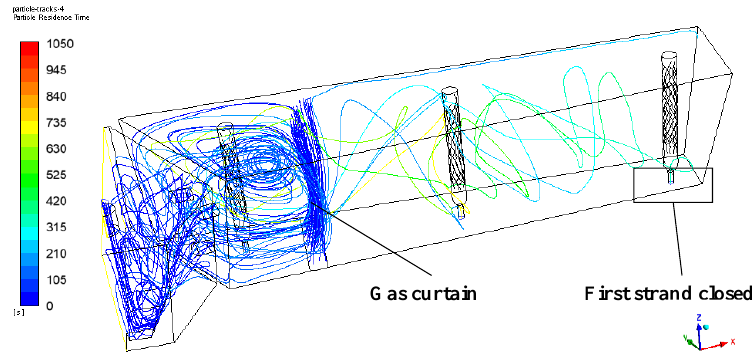
Figure 11. The trajectory of the inclusions in the tundish.